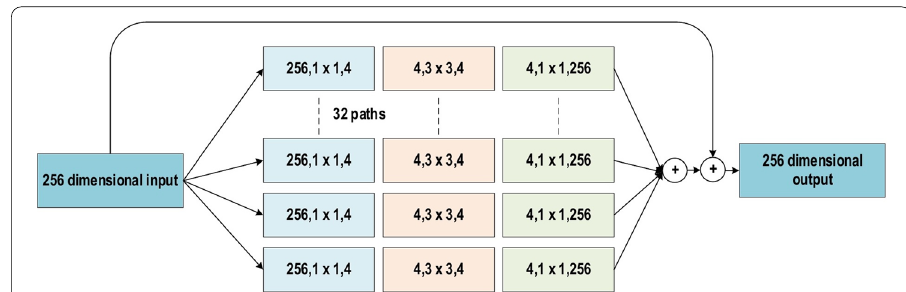
Fig. 23 The basic block diagram for the ResNext building